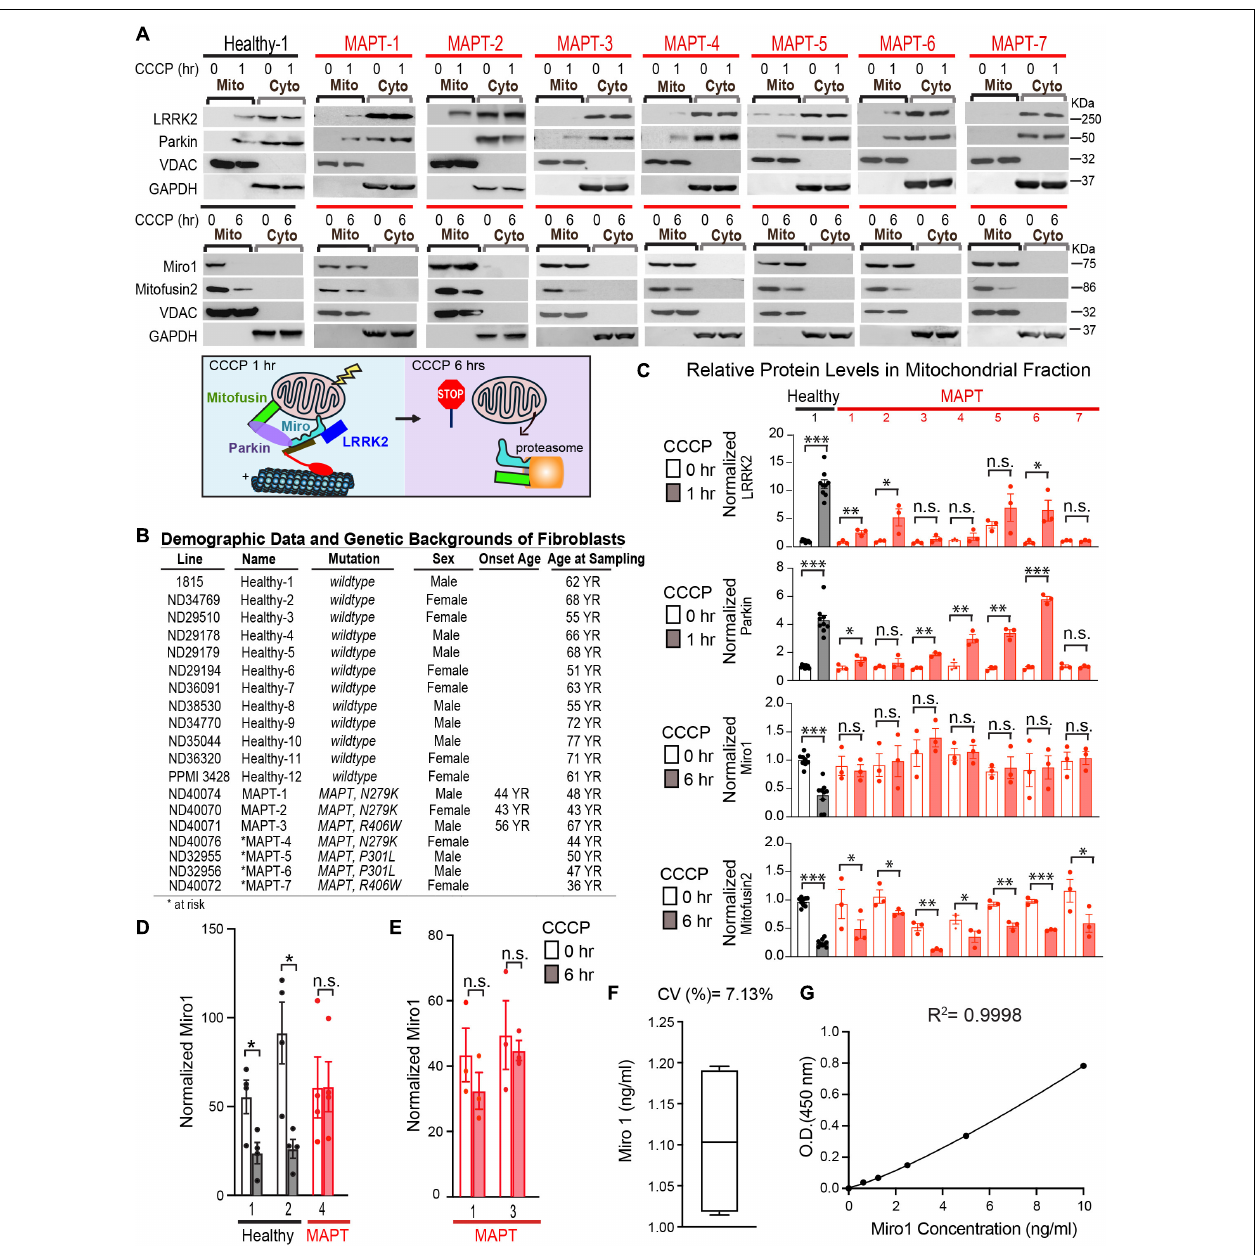
FIGURE 1 | Mitochondrial protein changes following CCCP treatment in fibroblasts. (A) Mitochondrial (Mito) and cytosolic (Cyto) fractions were immunoblotted as indicated. Below: Schematic representation of our readouts. (B) Demographic and genetic information of all cell lines used in this study or described in Text. (C) Quantifications of mitochondrial protein levels. The intensity of each band in the mitochondrial fraction is normalized to that of the mitochondrial loading control VDAC from the same blot and expressed as a fraction of Mean of Healthy-1 with DMSO treatment; this control was included in every experiment. Student T Test is performed for comparing normalized band intensities within the same subject (DMSO vs. CCCP). N = 3–9 independent experiments. Please note that Healthy-2 to 12 show similar mitochondrial protein responses to CCCP as Healthy-1, previously published in Hsieh et al. (2019). (D,E) ELISA of Miro1 protein. Comparison within the same subject. Mann-Whitney U Test. (D) N = 4 with duplicates each time. (E) N = 3. (F) Intra-plate variability of ELISA shown in (E) , measured by running the same fibroblast sample 4 times in the same plate. (G) The standard curve for (E) is shown. Sigmoidal 4PL is used. ∗ P < 0.05, ∗∗ P < 0.01, ∗∗∗ P < 0.001. n.s.: not